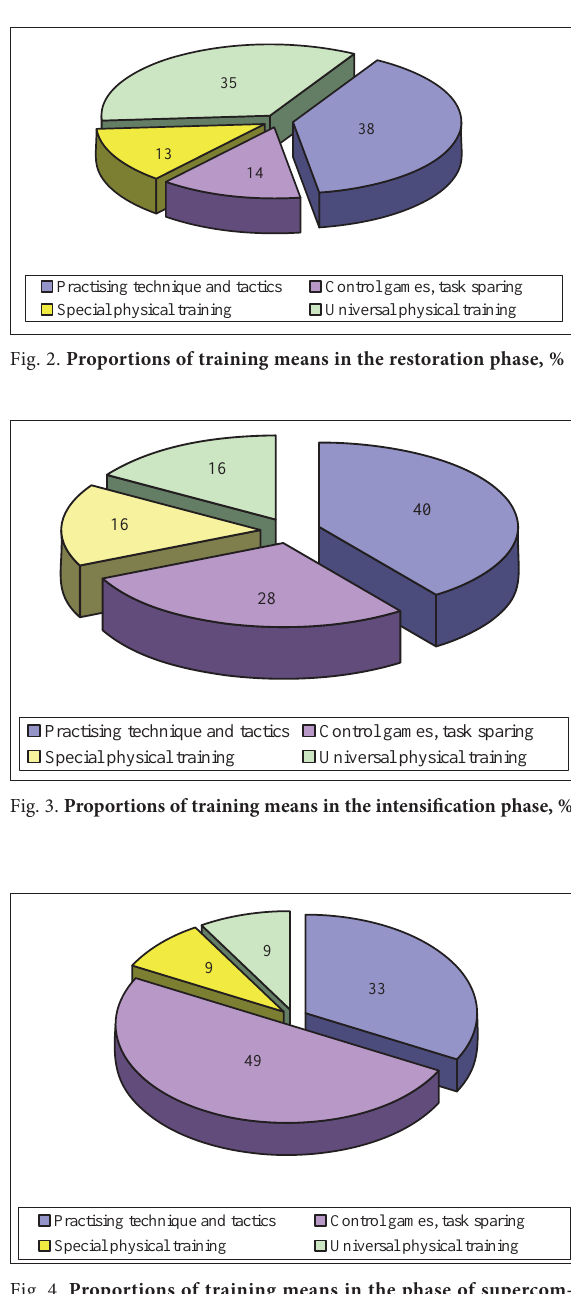
Fig. 4. Proportions of training means in the phase of supercom- pensation,